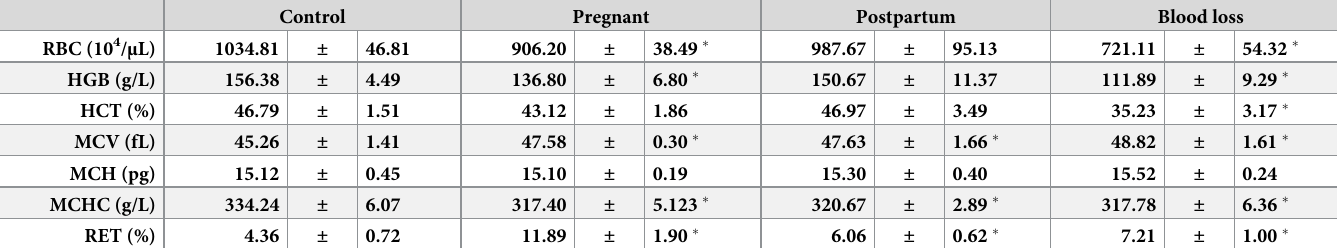
Table 2. Analyses of erythrocytes (RBCs) in uninfected pregnant and postpartum mice. Control Pregnant Postpartum Blood